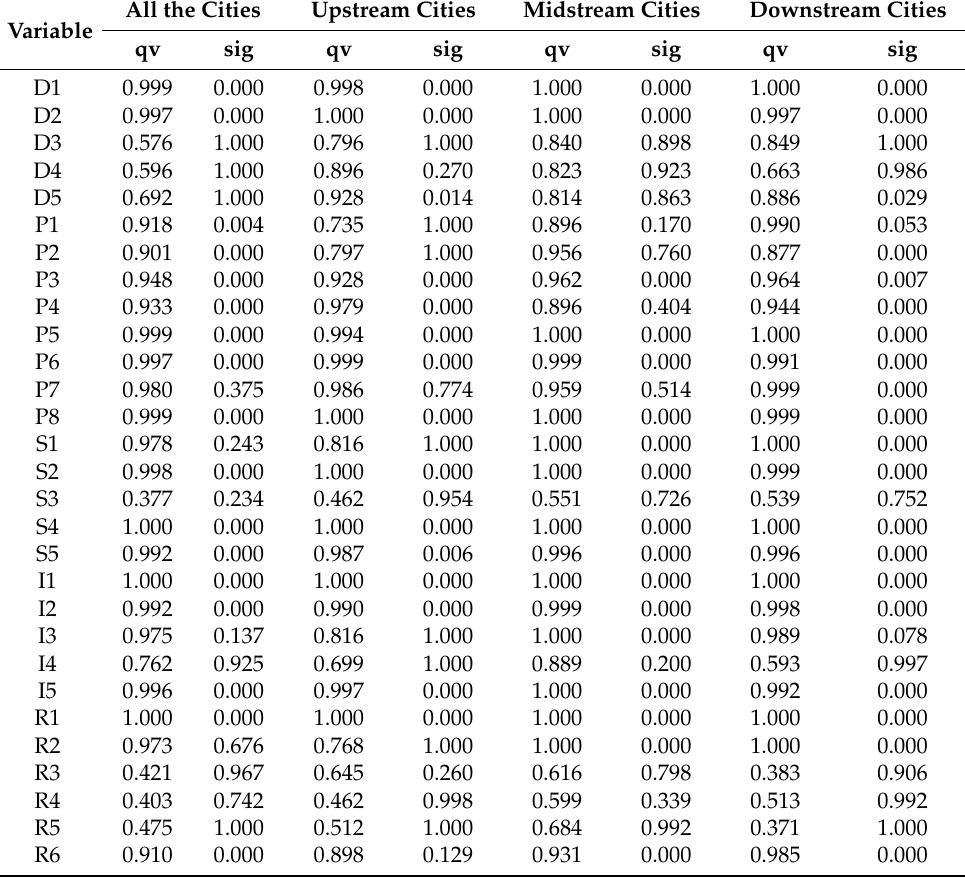
Table 4. Analysis results of influencing factors of